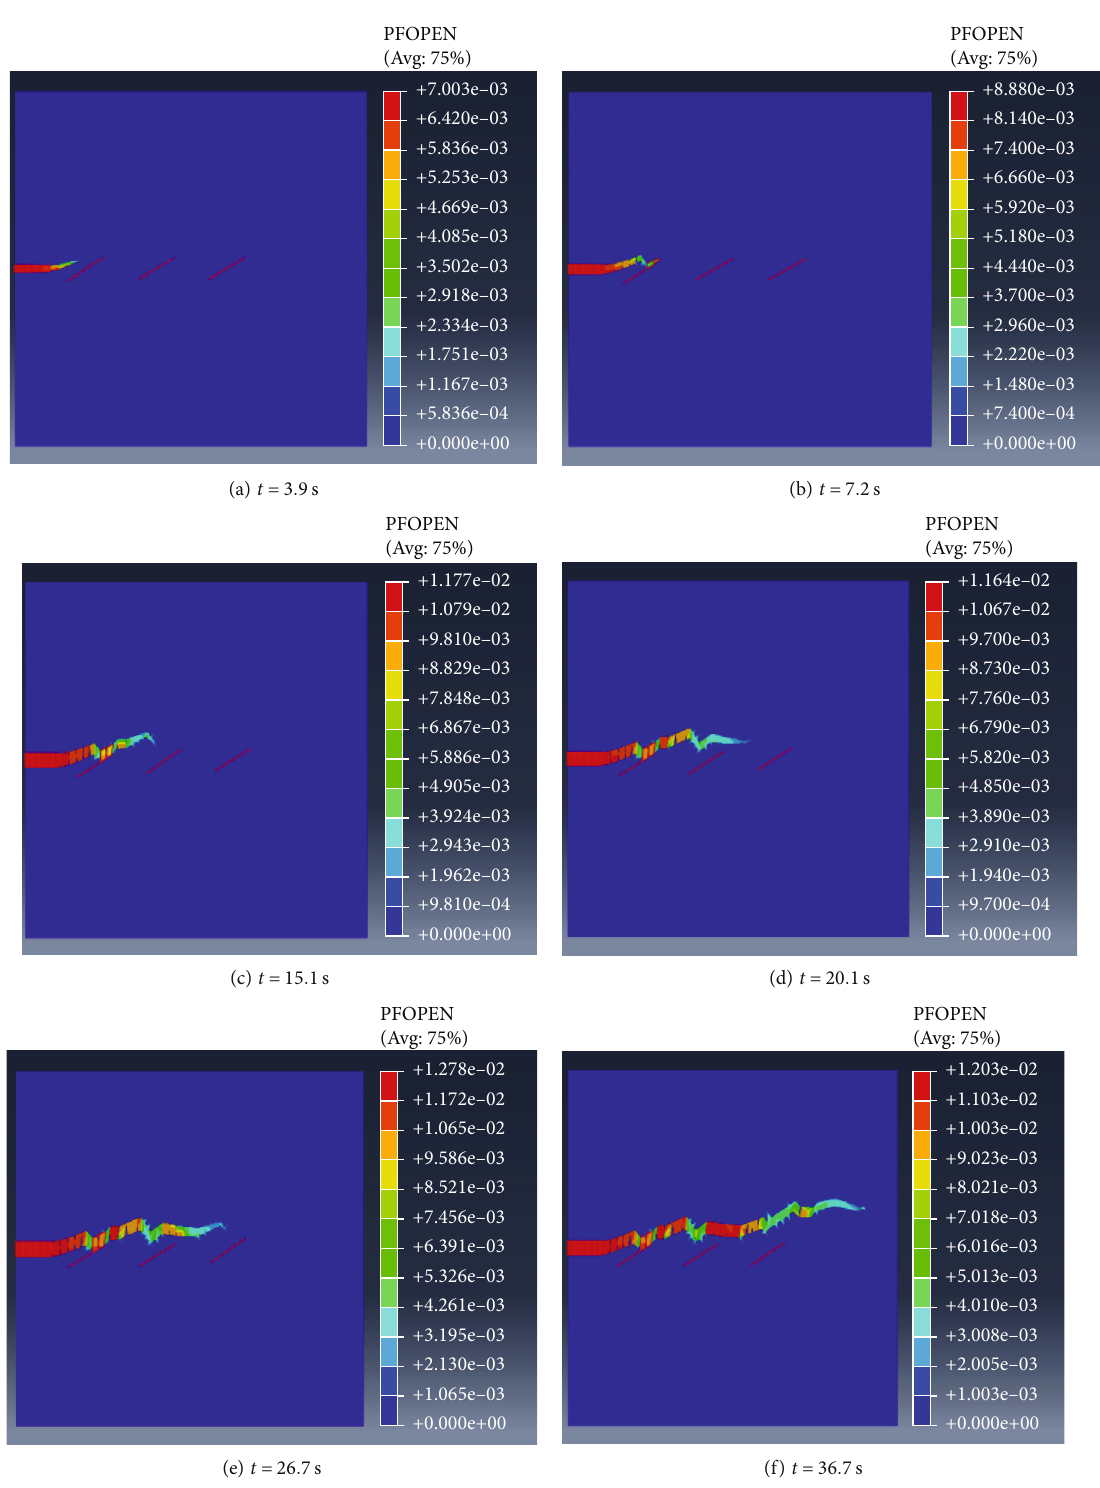
Figure 23: HF propagation at the NF approaching angle of 45 ° and stress anisotropy coe ffi cient of